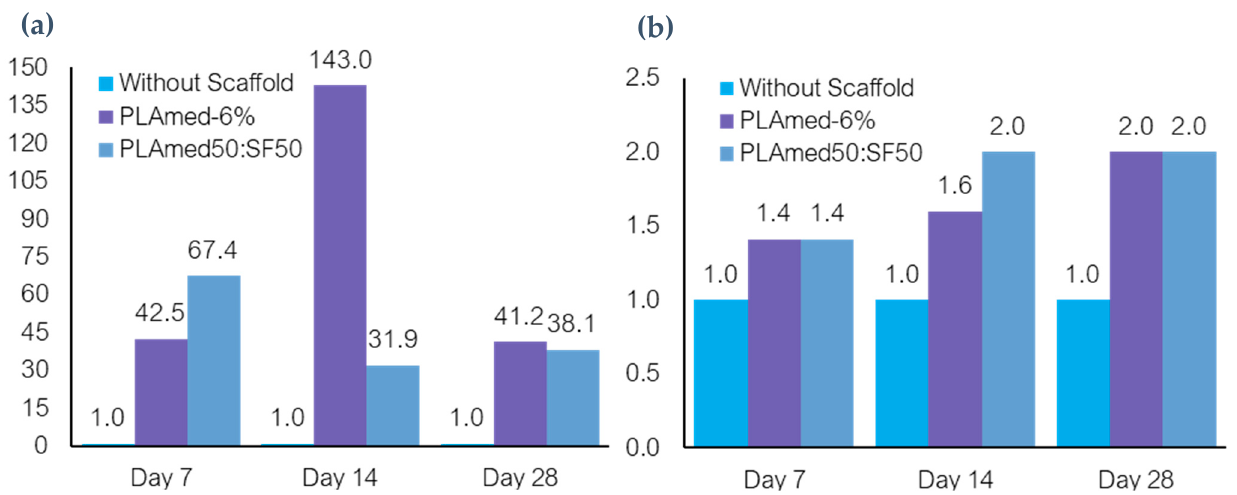
Figure 11. The expression of COL1A1 and COL2A1 at days 7, 14, and 28 were demonstrated in ( a , b ),